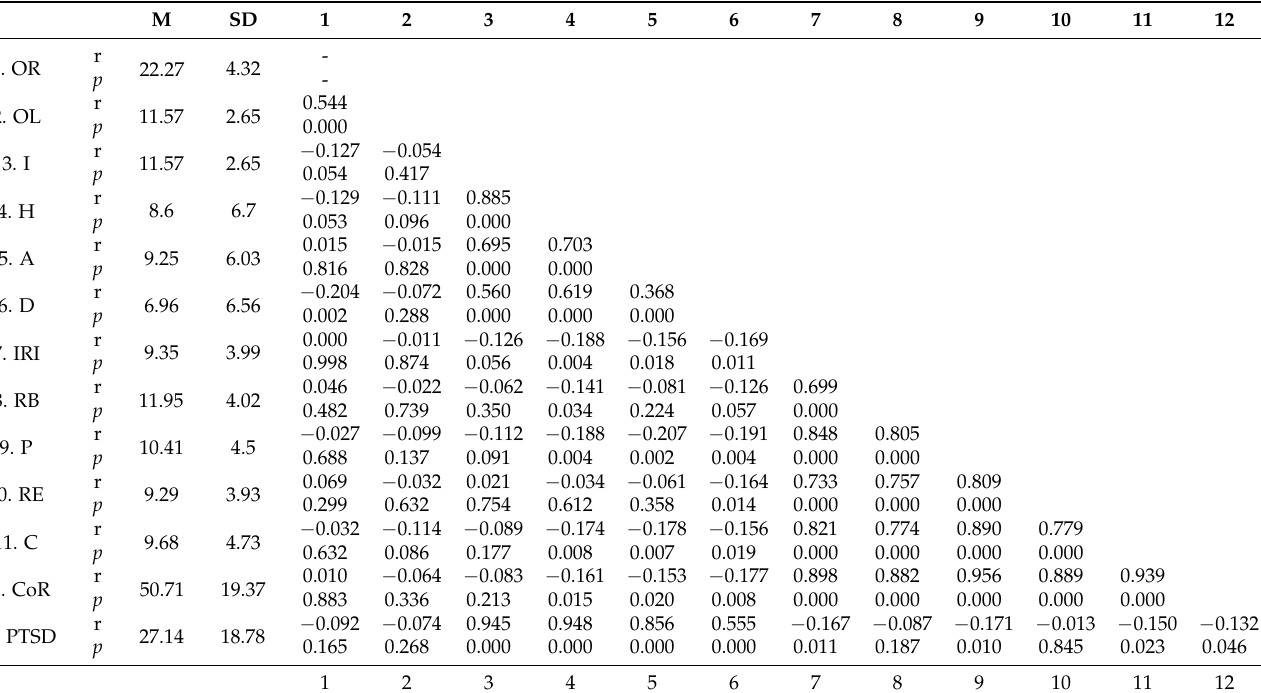
Table 2. Descriptive statistics and correlations among ego-resilience, religiosity, and psychopatholog- ical